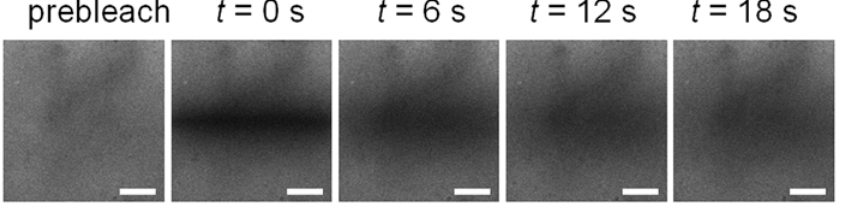
Fig 8. Representative FRAP image sequence. Data shown is for 40 kDa dextran in 10 mg/ml collagen hydrogel polymerized at pH 7.4 and 23°C. Left to right: Prebleach; t = 0 s, t = 6 s, t = 12 s, t = 18 s. Scale bar 50 μ